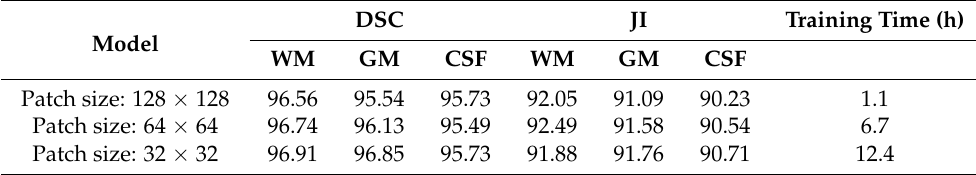
Table 5. Segmentation accuracy (%) and training time (hours) for the proposed method with different sizes of input